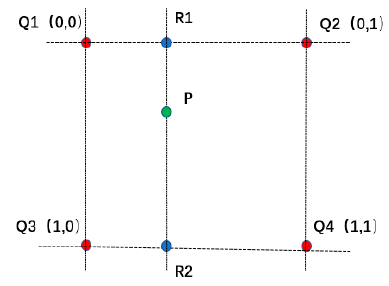
Figure 10. Bilinear interpolation schematic diagram.